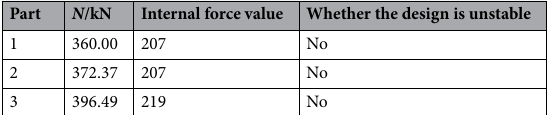
Table 3. Calibration of web member